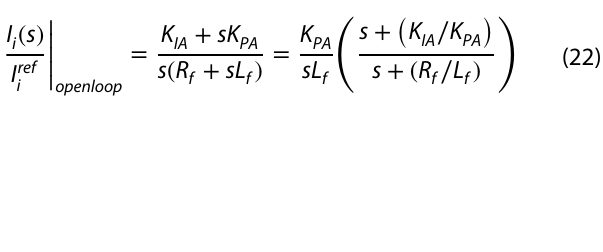
Table 6 Design constants used in EPI tuning